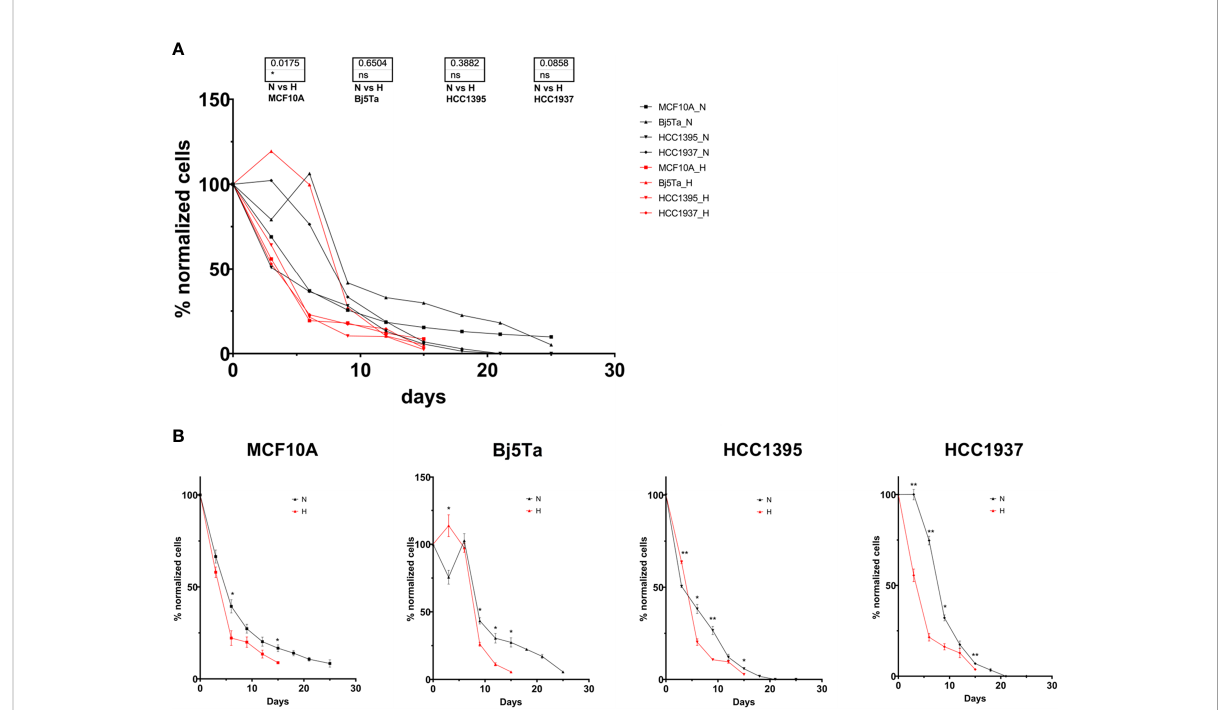
FIGURE 1 Cell proliferation capacity and growth rate during radiotherapy. The cell counts at speci fi c irradiation days were normalized to the number of cells seeded at the start of the experiment and plotted as a percentage for all investigated cell lines (A) , or each cell line individually (B) . The red line and H represent HypoRT; the black line and N represent NormRT. *p<0.05, **p<0.005, n.s, non-signi fi